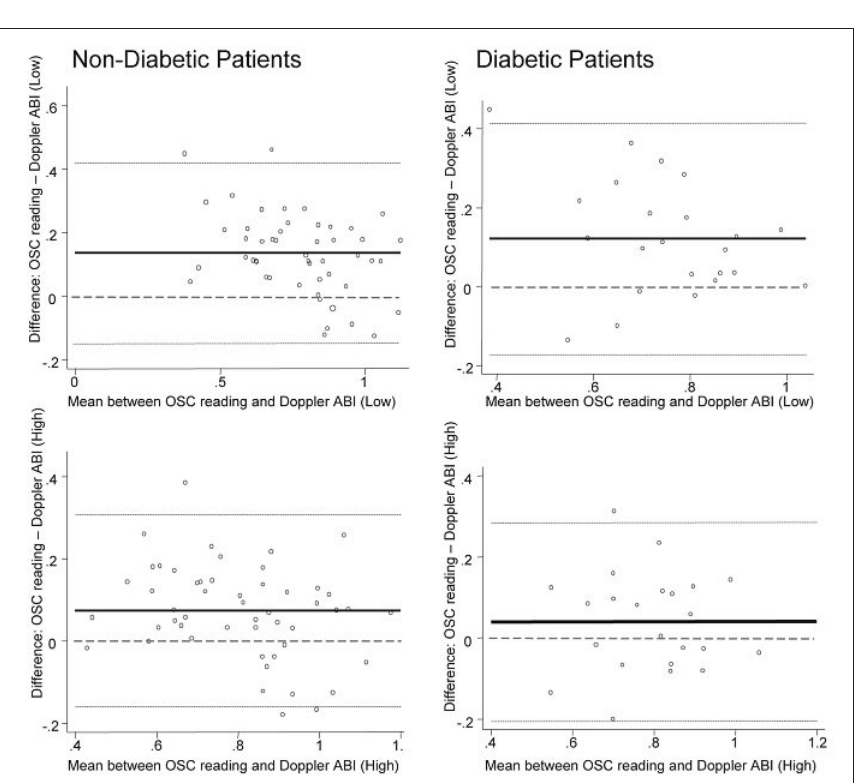
Figure 3 Bland-Altman plots of intermodality agreement between oscillometric (OSC) and Doppler-assisted low (top row) and high (bottom row) measurement of ankle brachial index (ABI), respectively. Horizontal line repre- sents the actual cen- tre of agreement, and the interrupted line the ideal centre of agreement. Dotted lines represent limits of agreement (i.e., 1.96 standard devia- tions of inter-modal- ity